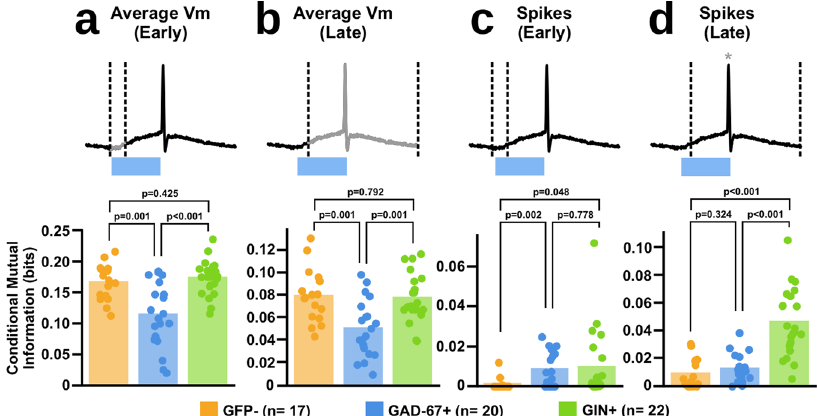
Fig. 8 Different subtypes of interneurons carry different amounts of information in response to our rate encoding. a Mutual information analysis of the average membrane potential of each cell type to our 1-bit signal within early (0 – 5 ms) response. Dotted lines indicate window of analysis, with greyed areas indicating what part of the response was analysed (Kruskal – Wallis, H(2) = 13.9, p ≤ 0.001; post-hoc t -tests: GFP − vs. GIN + : t(37) = − 0.806, p = 0.425; GAD67 + vs. GIN + : t(40) = − 4.17, p ≤ 0.001*; GFP − vs. GAD67 + : t(35) = 3.48, p = 0.001*, * = tests signi fi cant at p ≤ 0.017 with Bonferroni correction). b Same analysis as ( a ) but restricting the analysis to only the later (5 – 50 ms) responses (One-way ANOVA, F(2,56) = 3.10, p = 0.053; post-hoc t -tests: GFP- vs. GIN + : t(37) = 0.266, p = 0.792; GAD67 + vs. GIN + : t(40) = − 1.98, p = 0.054; GFP − vs. GAD67 + : t(35) = 1.93, p = 0.062, * = tests signi fi cant at p ≤ 0.017 with Bonferroni correction). c Mutual information analysis of the spike counts of each cell type to our 1-bit signal within early (0 – 5 ms) response (One-way ANOVA, F(2,56) = 2.93, p = 0.066; post-hoc t -tests: GFP − vs. GIN + : t(37) = − 2.04, p = 0.048; GAD67 + vs. GIN + : t(40) = − 0.226, p = 0.778; GFP − vs. GAD67 + : t(35) = − 3.66, p = 0.002*, * = tests signi fi cant at p ≤ 0.017 with Bonferroni correction). d Same analysis as ( c ) but restricting the analysis to only the later (5 – 50 ms) responses (Kruskal – Wallis, H(2) = 30.5, p ≤ 0.001; post-hoc t -tests: GFP − vs. GIN + : t(37) = − 6.42, p ≤ 0.001*; GAD67 + vs. GIN + : t(40) = − 5.92, p ≤ 0.001*; GFP − vs. GAD67 + : t(35) = − 1.14, p = 0.324, * = tests signi fi cant at p ≤ 0.017